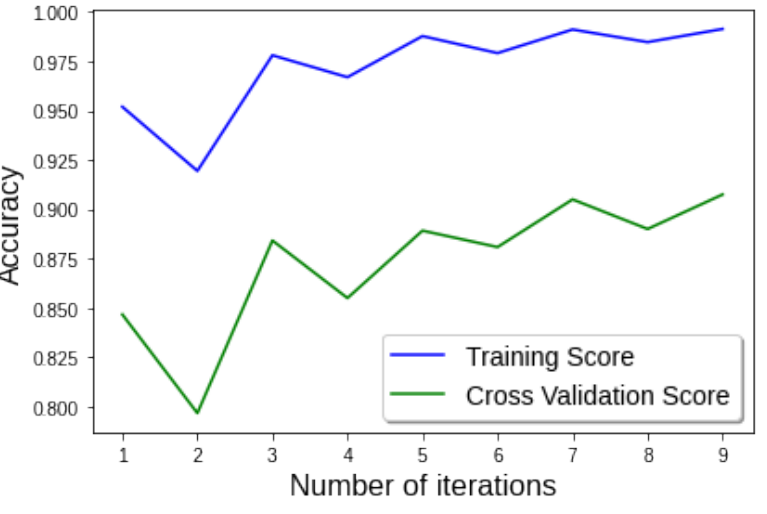
Figure 9. Train and cross validation of Ranker